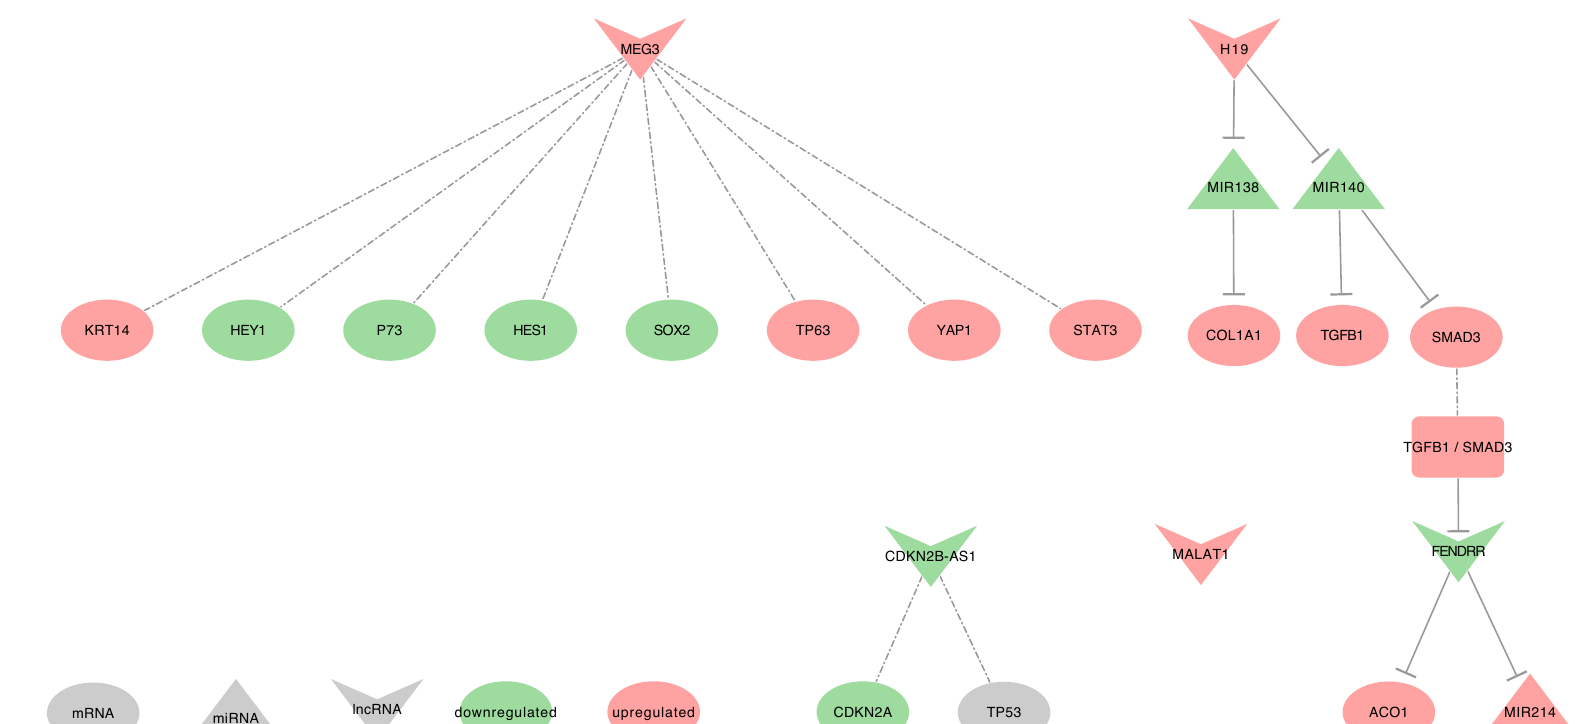
Figure 2. The selected eight lncRNAs in Idiopathic Pulmonary Fibrosis (IPF): A network of lncRNA-miRNA-Protein interactions. Upregulated molecules are in green. Downregulated molecules are in red. Up or down-regulated molecules are in purple. Shape definitions are in grey. Gray arrows target the activated molecules. T-ended lines target the inhibited molecules. Square-ended lines represent a binding between molecules. Dashed-dot lines represent an association with unknown